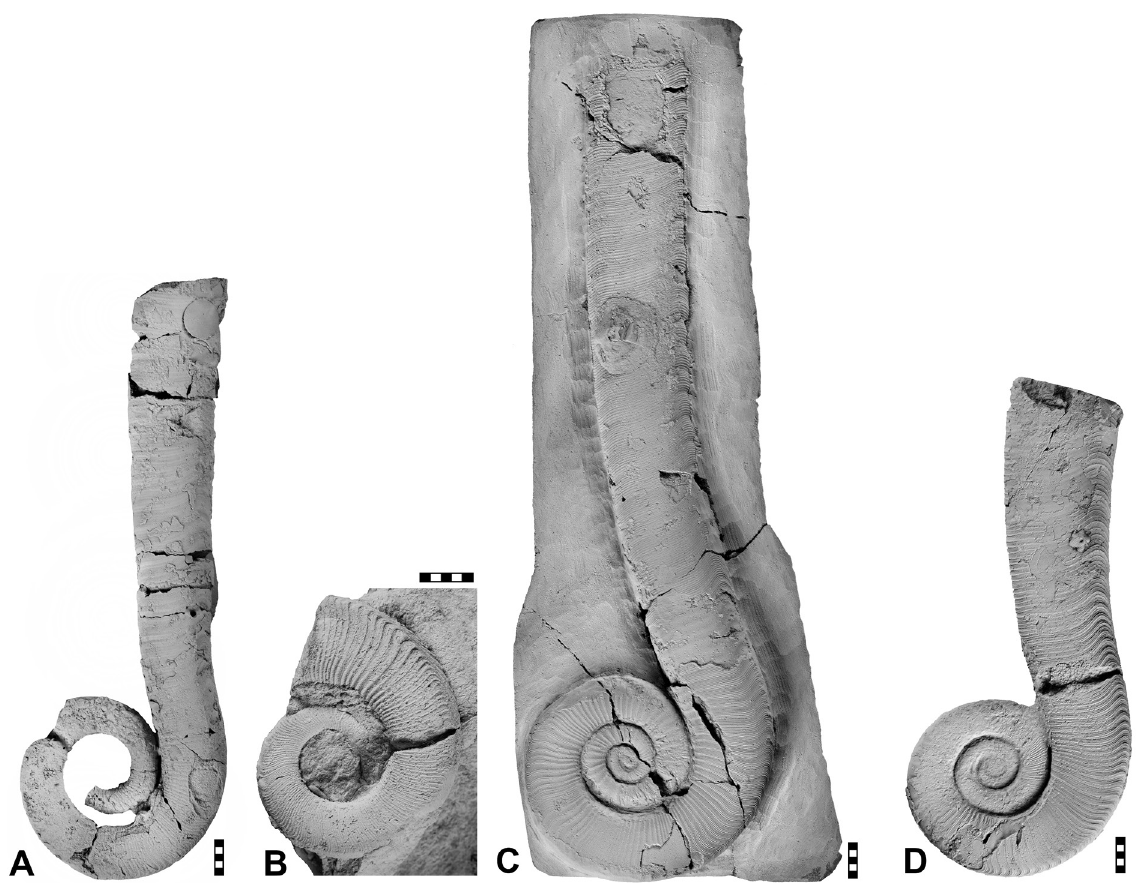
Fig. 66. Species of Trilacinoceras Sweet, 1958 from the Upper Grey Orthoceratite Limestone. A . Trilacinoceras discors (Holm, 1891), specimen MB.C.30552 (Neben & Krueger Coll.) from Niederfinow (Brandenburg); previously figured by Neben & Krueger (1971: pl. 21 fig. 1). B . Trilacinoceras discors (Holm, 1891), specimen MB.C.30553 from Schwedt (Brandenburg). C . Trilacinoceras knoefleri sp. nov., holotype MB.C.11658 (Knöfler Coll.) from Teschendorf near Löwenberg (Brandenburg). D . Trilacinoceras knoefleri sp. nov., paratype MB.C.30559 (Krueger Coll.) from Mukran (Sassnitz, Island of Rügen) (Mecklenburg-Vorpommern). Scale bar units = 1